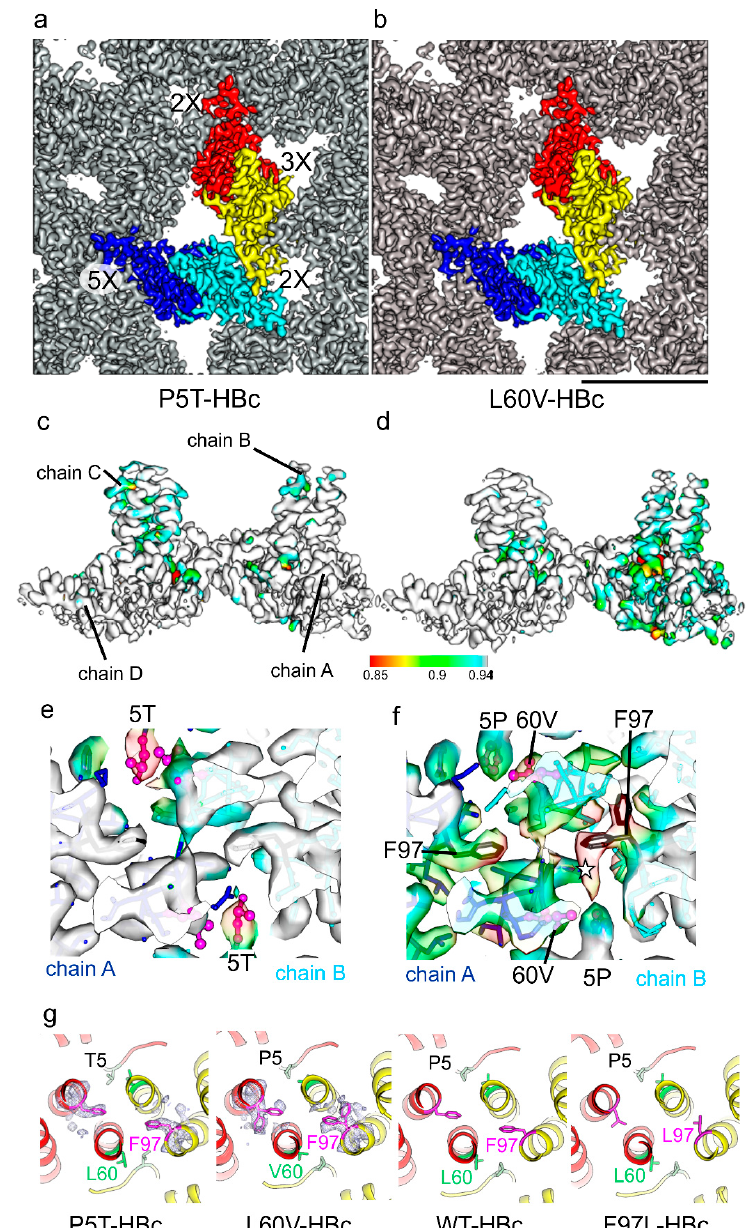
Figure 3. Structure determination of the low secretion phenotype mutants P5T-HBc ( a , c , e ) and L60V-HBc ( b , d , f ). Close-up of the capsid surface of P5T-HBc ( a ) and L60V-HBc ( b ). One asymmetric unit of the icosahedral capsid is colored with different colors as follows: chain A: blue; chain B cyan, chain C yellow and chain D red. The nearest 2-fold, 3-fold and 5-fold symmetry axes are indicated in ( a ) The scale bar in ( b ) indicates 5 nm and applies for panels ( a , b ); ( c , d ) show the maps for an asymmetric unit colored with its local correlation with the map of WT-HBc determined in this study. All maps are filtered to a resolution of 3.5 Å and scaled to give the same radial intensity distribution of the power spectra. The color key for the local correlation is given below. Its length corresponds to 5 nm and applies for ( c , d ); ( e , f ) show a 1 nm thick slice through the center of the AB spike where the local correlation is lowest in L60V-HBc. The maps are fitted with the respective models. Areas with lower correlation are also more transparent. Residues 5 and 60 are shown in magenta; residue 97 is shown in black. In P5T-HBc, the local correlation is lowest at the point mutation but leaves the spike unaffected. In L60V-HBc, the low local correlation identifies an unaccounted density (star) and two alternate orientations of F97; ( g ) shows a comparison of the models of P5T-HBc, L60V-HBc, WT-HBc and F97L-HBc (6HU4 [39]) at the center of the CD spike viewed along the dimer axis. Chain C is colored in yellow and chain D in red. The side chains of residues 5, 60 (green) and 97(magenta) are shown in all four models. The mutation L60V destabilizes the rotamer orientation of F97 that adopts two alternate positions in L60V-HBc. The density around F97 is shown as mesh in P5T-HBc and